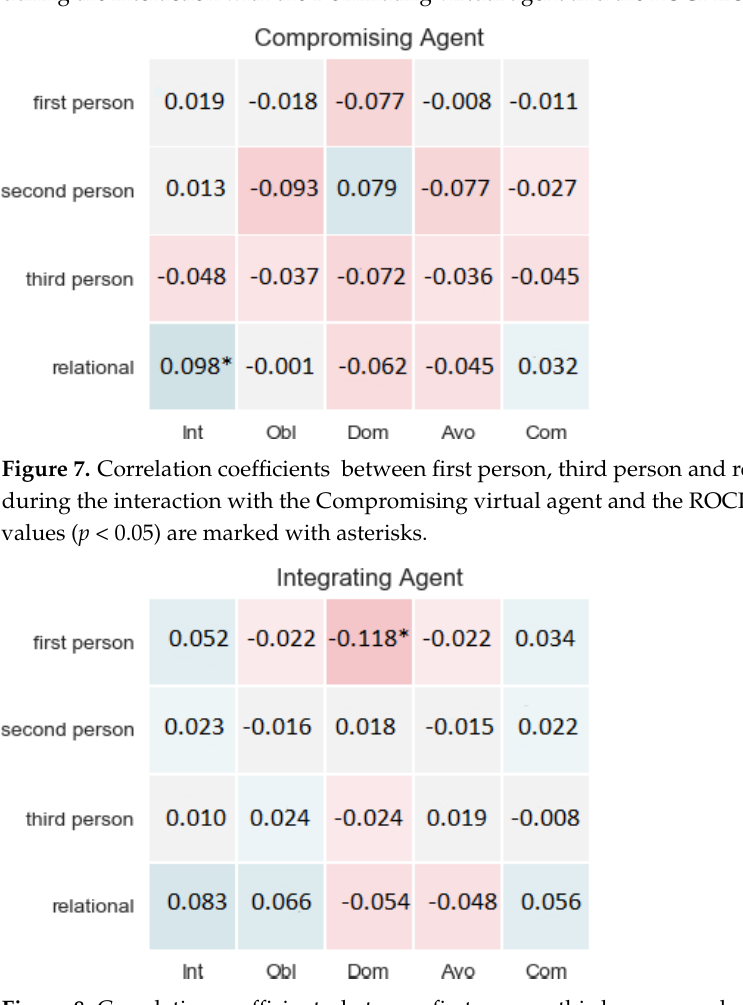
Figure 8. Correlation coefficients between first person, third person and relational pronouns used during the interaction with the Integrating virtual agent and the ROCI-II scores. (*) Significant values ( p < 0.05) are marked with